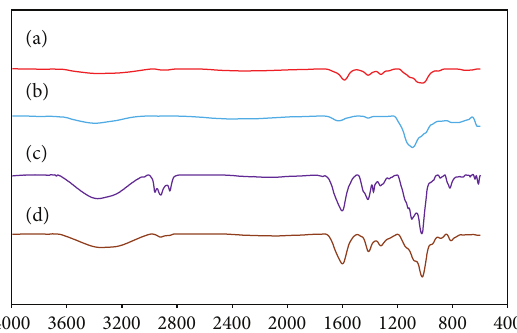
Figure 4: ATR-FTIR spectra of (a) CMC, (b) SA, (c) 10: 5 SA/CMC blend, and (d) 10: 5 CMC SA/CMC blend crosslinked with Ca 2+